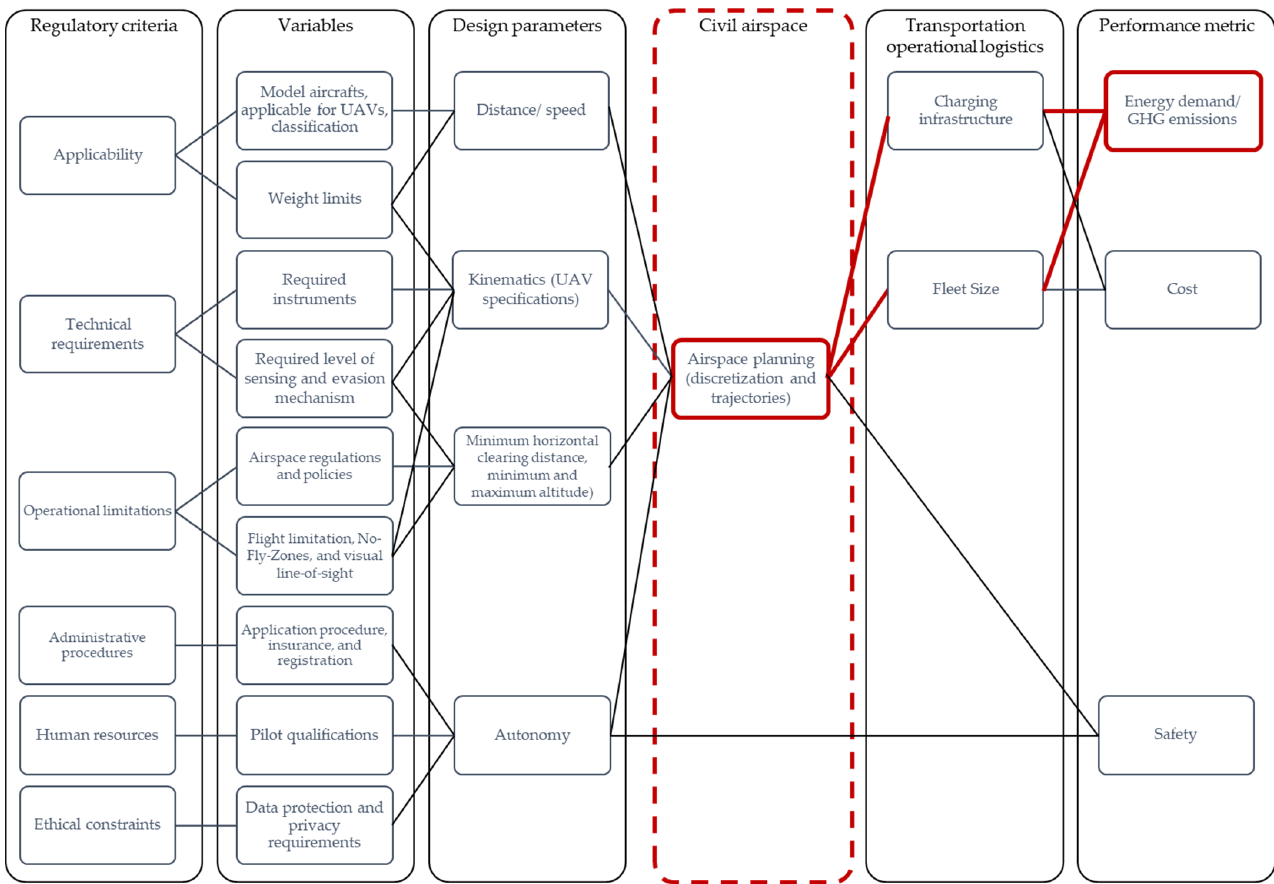
Figure 1. Regulatory criteria correlation to performance metrics.